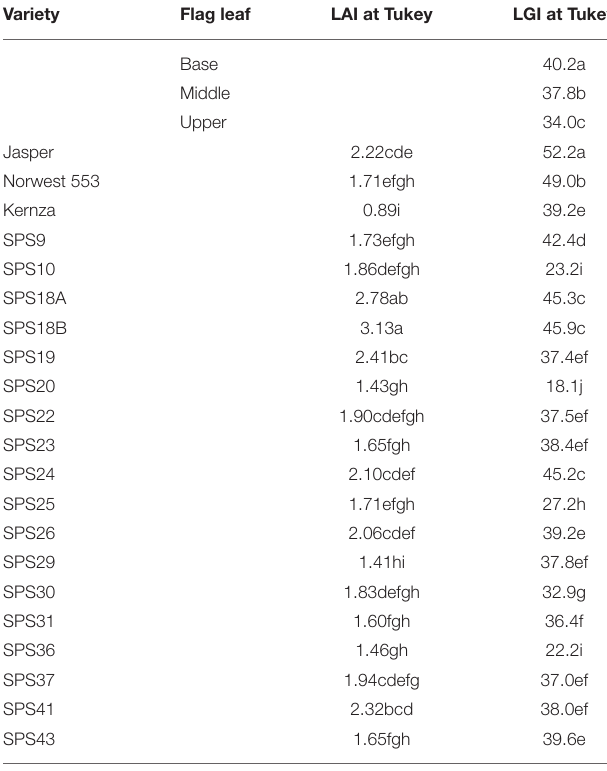
TABLE 3 | Mean leaf area index (LAI) and mean leaf greenness index (LGI) at the Tukey location for all varieties. Mean LGI based on portion of the flag leaf (base, middle or upper portion) was measured on 21 June 2016.